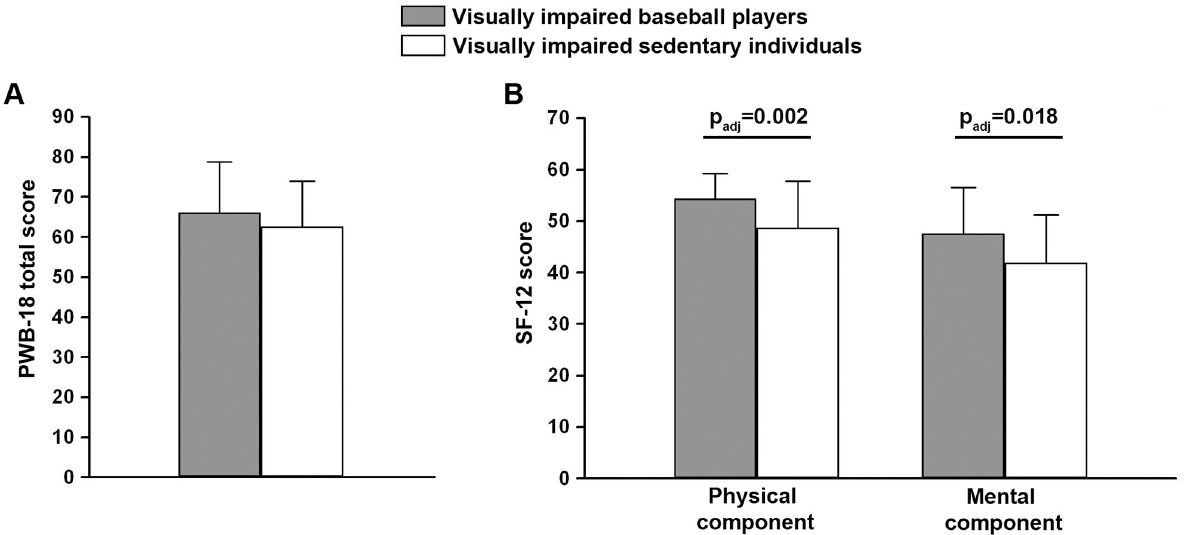
than either blind or mildly sight-impaired (B1 and B3 classifications, respectively) subjects (Table 5). In particular, severely sight-impaired baseball players reported a statistically signifi- cant lower value of PWB-18 personal growth subscale compared with the blind athletes (p = adj 0.026). Of note, the mildly sight-impaired athletes showed a significantly higher SF-12 mental score respect to blind athletes (p = 0.035) (Table 5). Instead, no significant difference was adj found according to either gender or congenital/acquired visual disability. Similarly, no signifi- cant difference could be detected between baseball players practicing other sports and those who only practiced baseball.